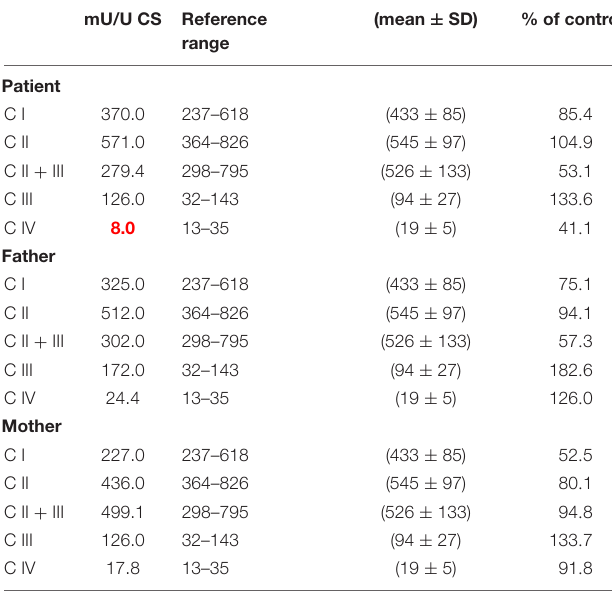
TABLE 1 | Mitochondrial enzyme activities in cultured fibroblasts derived from the patient and her parents. mU/U CS Reference